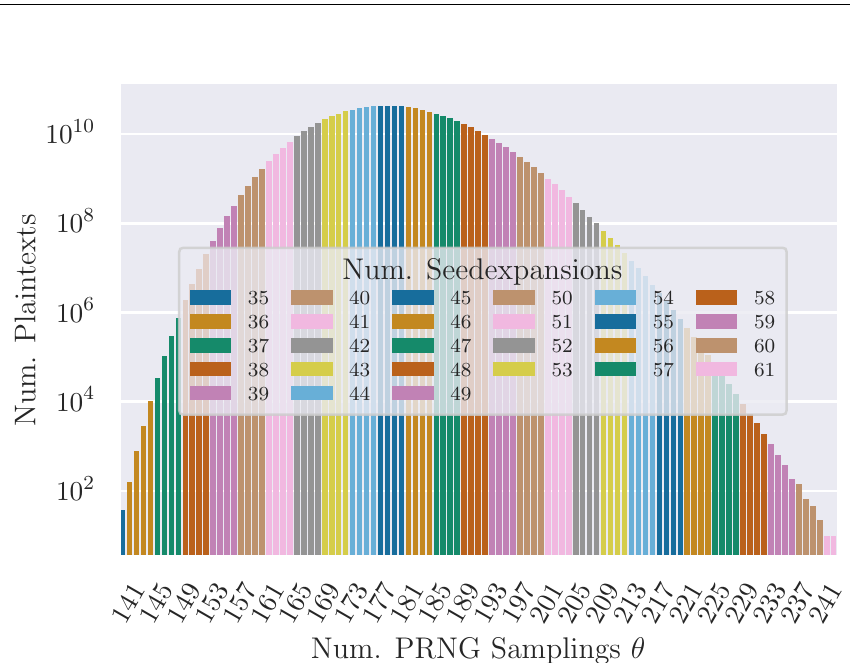
Figure 5: BIKE-L1 : Distribution of the number of samplings θ in H to the underlying PRNG function as empirically simulated with approximately 10 11 randomly generated plaintexts. Also presented are the number of seed expansions to the PRNG